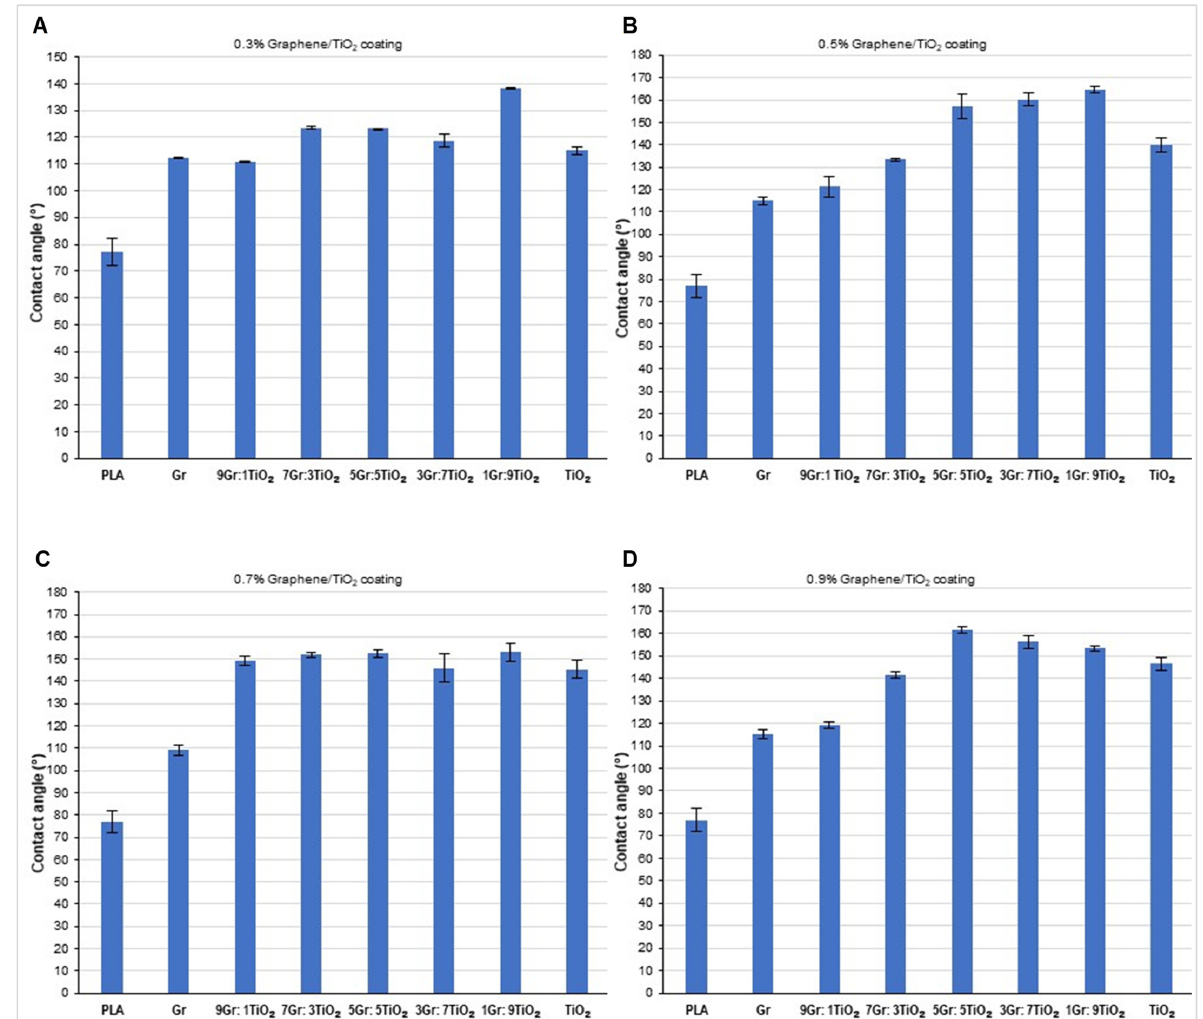
Figure 2. Water contact angle of the PLA film coated with ( A ) 0.3% w/v graphene/TiO 2 , ( B ) 0.5% w/v graphene/TiO 2 , ( C ) 0.7% w/v graphene/TiO 2 , and ( D ) 0.9% w/v graphene/TiO 2 . PLA without coating acts as a control; Gr represents graphene and TiO 2 represents titanium